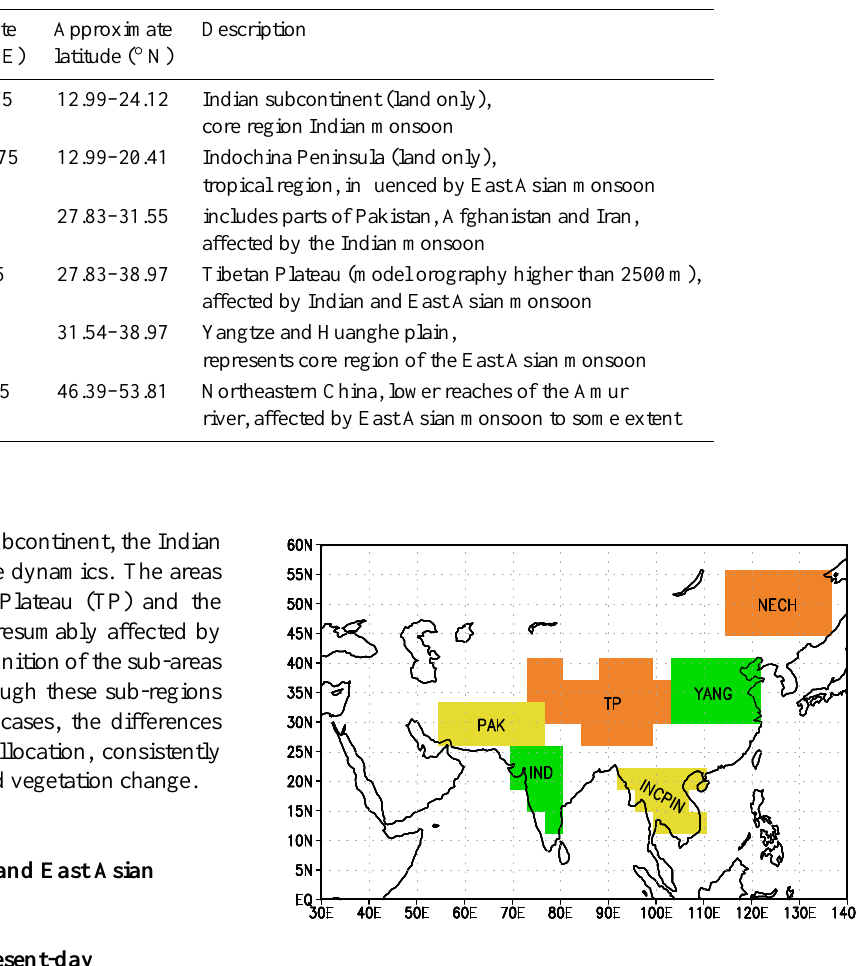
Fig. 1. Location of the areas we consider in our feedback